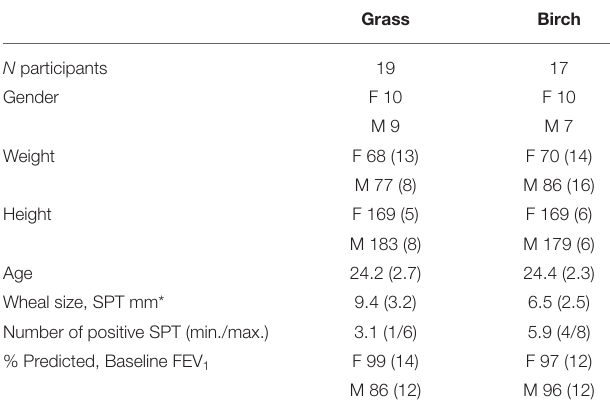
TABLE 1 | The study participant characteristics, mean (SD).